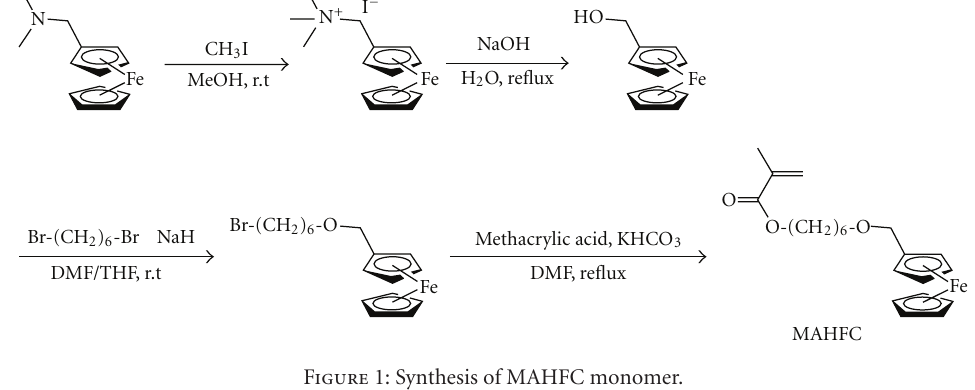
Figure 1: Synthesis of MAHFC monomer.